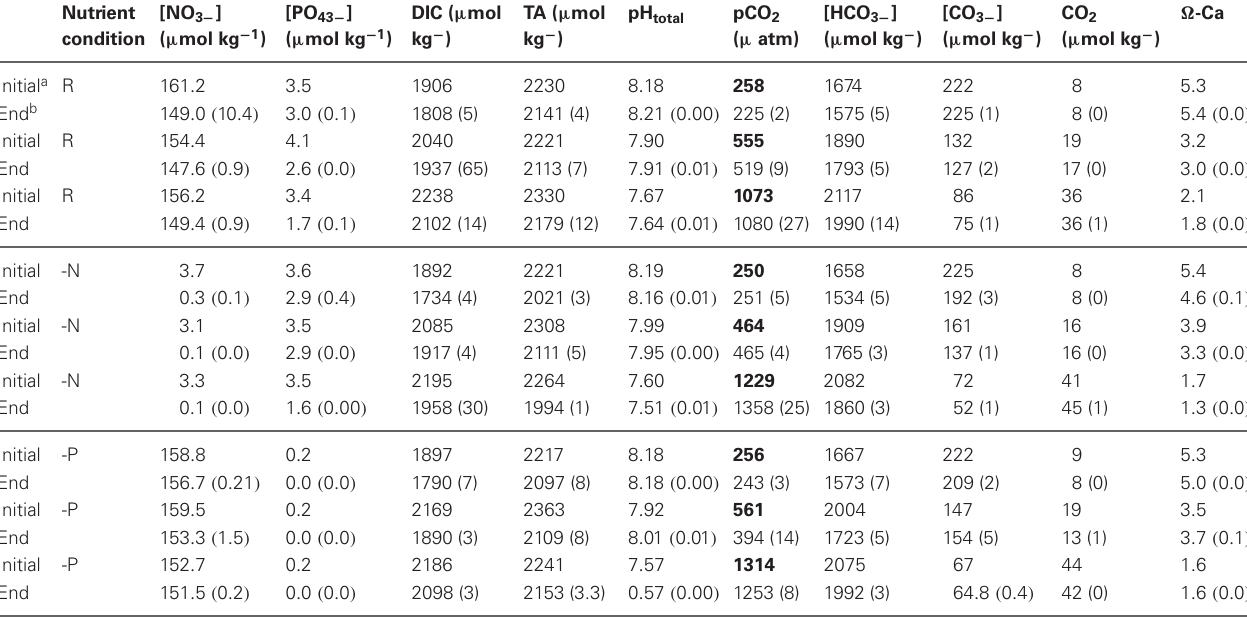
Table 1 | Nutrient concentrations and carbon chemistry parameters of the media at the beginning and at the end of the experiment. Nutrient